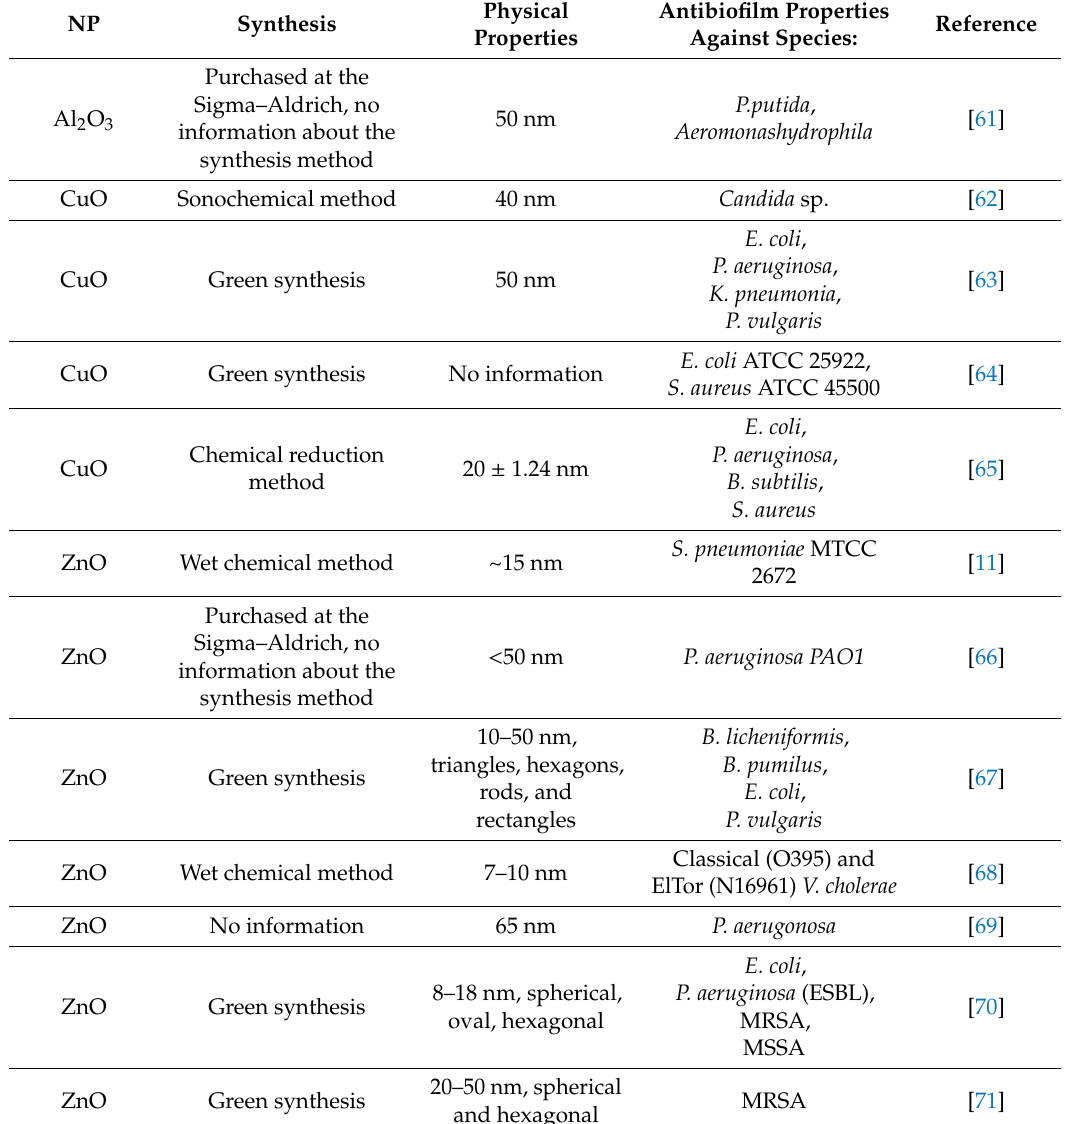
Table 1. Physical and antibiofilm properties of metal oxide nanoparticles (NPs) and nanocomposites.